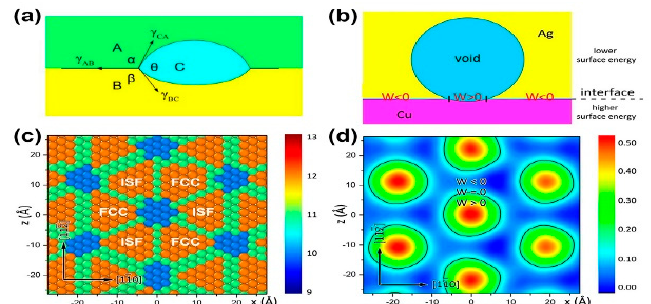
Figure 7. ( a ) Schematic of wetting model on interfaces. ( b ) Schematic of a void wetting a single misfit dislocation interaction (MDI) where W > 0 at a Cu/Ag interface. ( c ) Misfit dislocation network in the cube-on-cube Cu/Ag interface. Atoms shown are on the Cu side of the interface and colored by coordination number. ( d ) Contour plot of the location-dependent interface energy of a Cu/Ag interface. Black contours correspond to zero wetting energy [33].